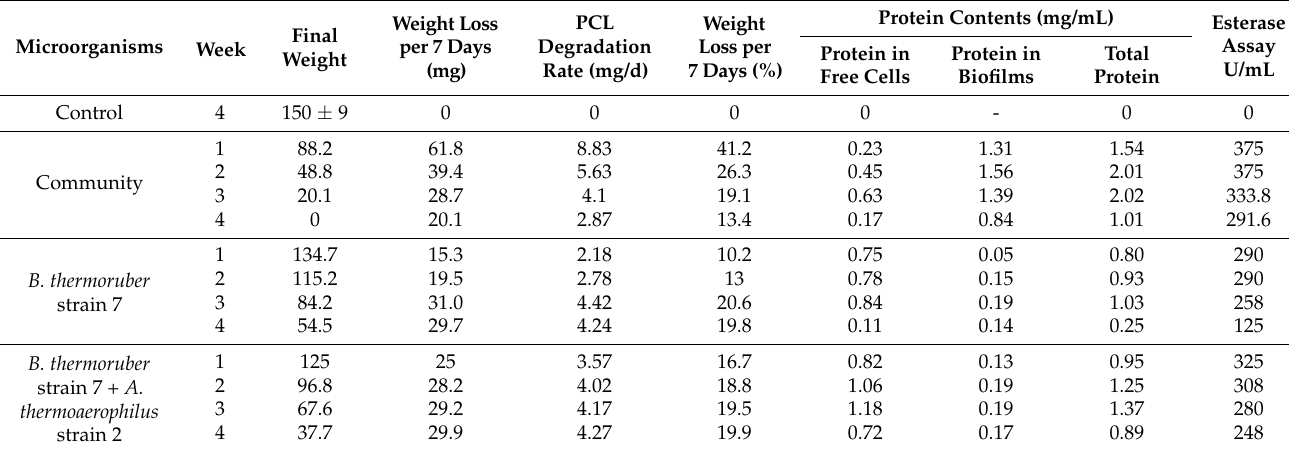
Table 4. Efficiency of PCL degradation by MKC-P, B. thermoruber strain 7, and B. thermoruber strain 7 + A. thermoaerophilus strain 2.